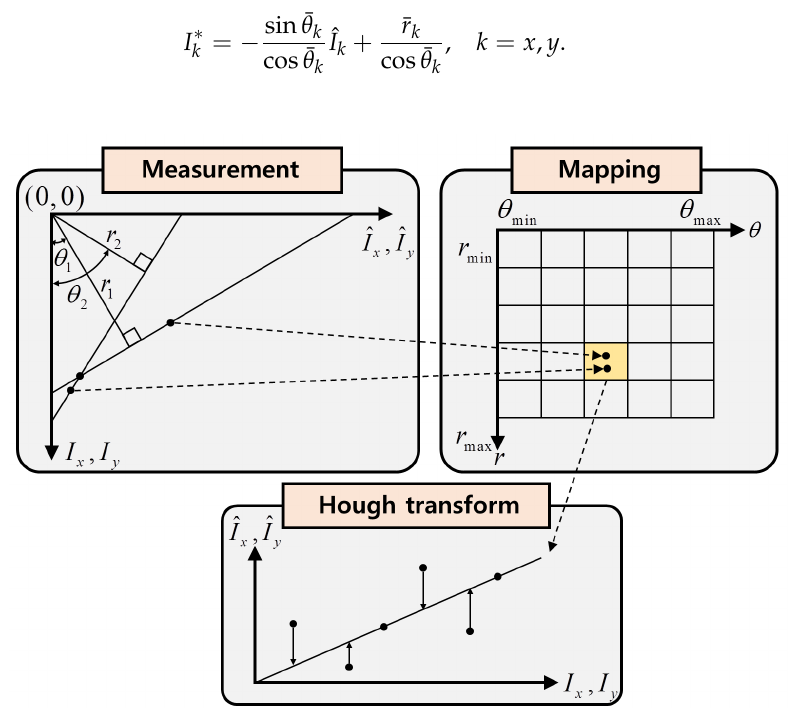
Figure 2. Application of the Hough transform in laser